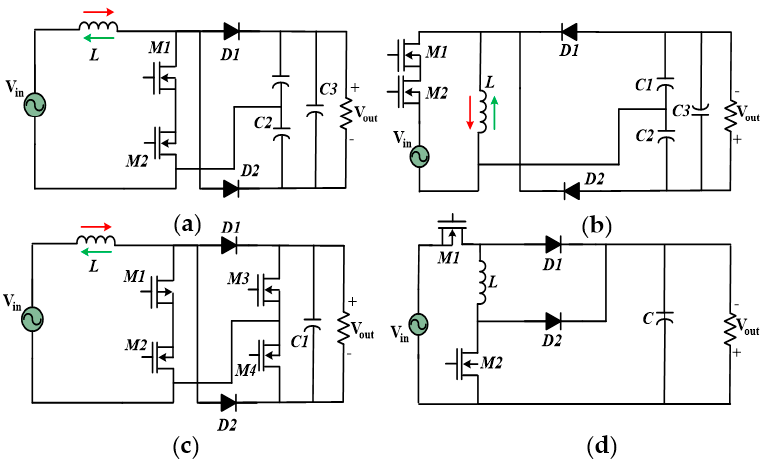
Figure 28. AC to DC switch converter topologies: ( a ) dual capacitor boost converter, ( b ) dual capacitor buck–boost converter, ( c ) boost converter with secondary switches, and ( d ) bridgeless boost-rectifier [133]. Table 2. Comparison of different AC-DC converters topology for energy harvesting. Refs.